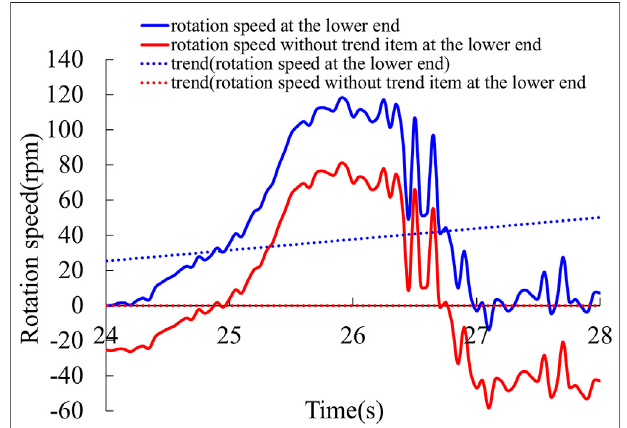
FIGURE 8 | Original signal and signal without trend item of rotation speed at the lower end of drill string.